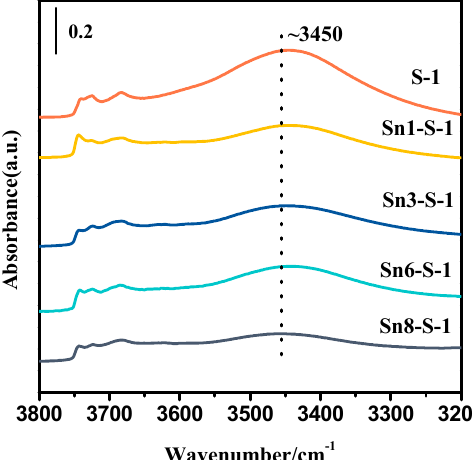
Figure 5. Hydroxyl stretching FI-IR spectra of defective S-1 and the Sn-containing defective S-1 zeolite catalysts with different Sn loadings.